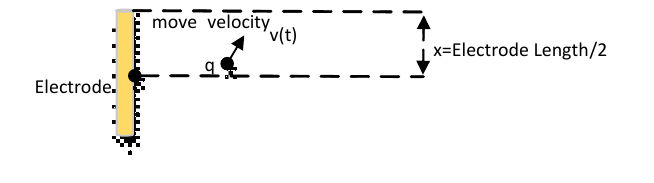
Figure 14. Moving point charge model.